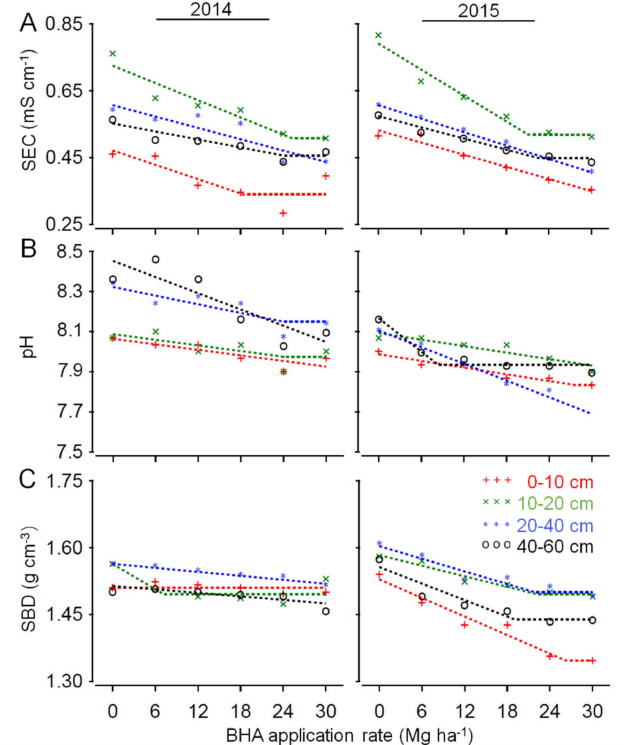
Figure 2. Means of ( A ) soil electrical conductivity, ( B ) pH, and ( C ) bulk density (SBD) measured at crop harvest in 2014 and 2015 in the 0–60 cm soil profile plotted against one-time bentonite-humic acid (BHA) application rate. The response of dependent variable (Y) to the BHA application rate (X) for each depth was fitted individually to a separate piecewise linear plus plateau model (dotted lines). The slopes of the regression lines were significant ( p < 0.05) for all parameters, except 0–10 cm and 20–60 cm for soil bulk density in 2014. Colors indicate different soil depths in all panels: 0–10 cm (red plus), 10–20 cm (green × ), 20–40 cm (blue asterisk), and 40–60 cm (black